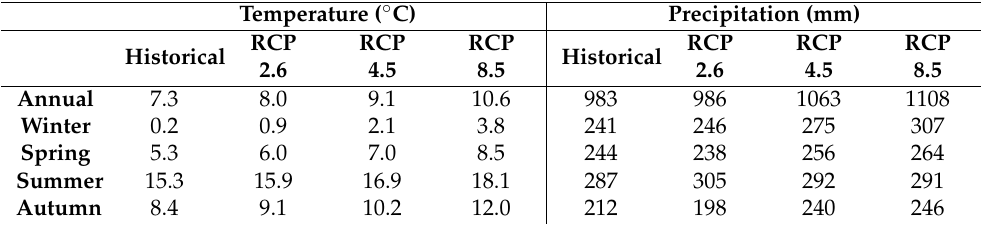
Table 3. Annual and seasonal temperature and precipitation loads for the historical period (H) and RCP projections.